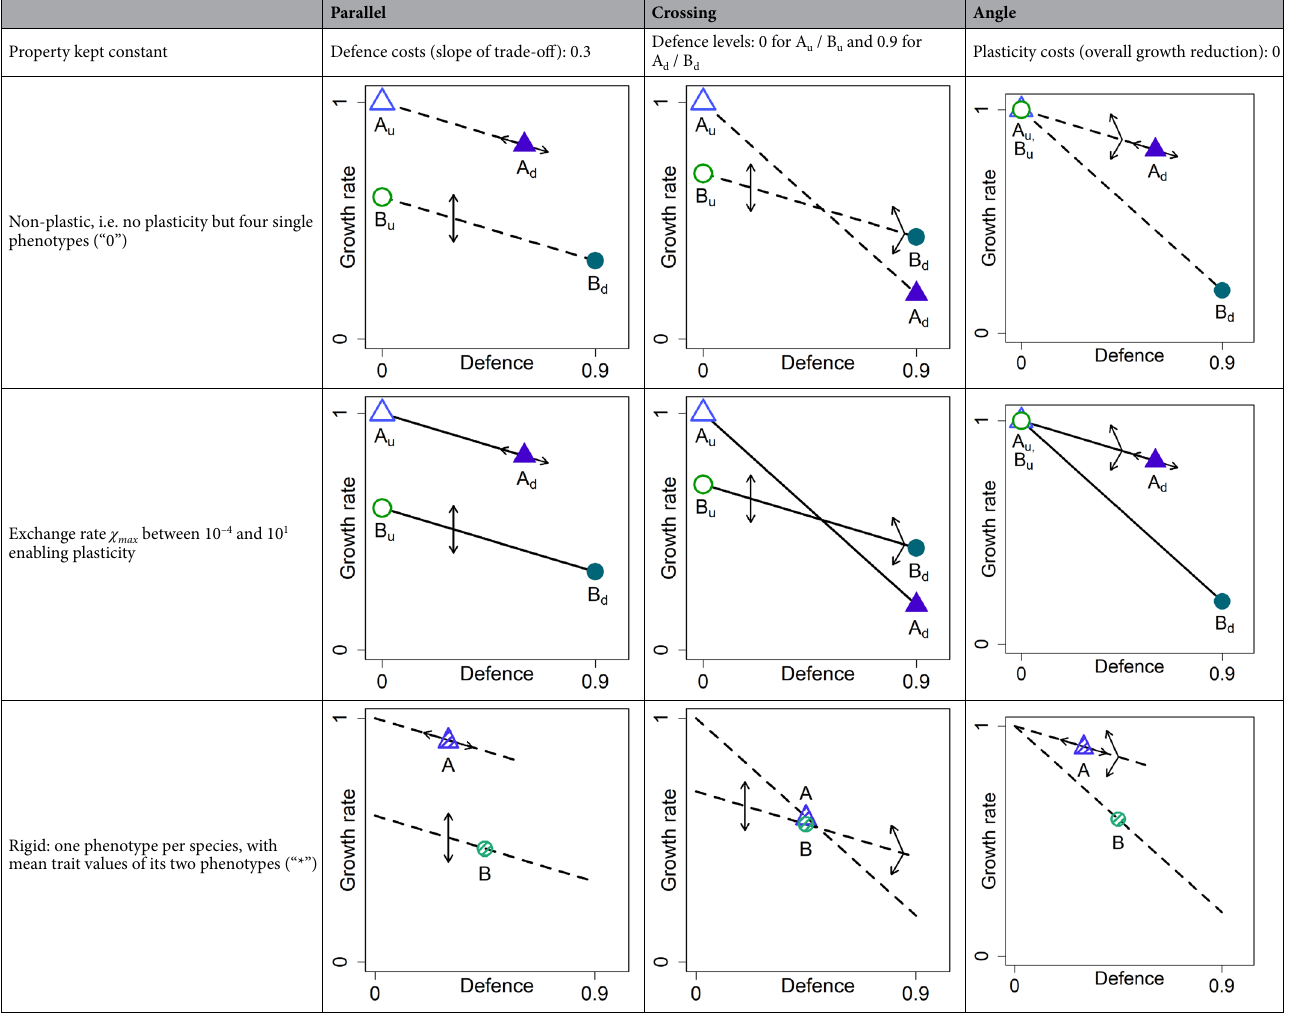
Table 1. Description of the three constellations parallel , crossing , and angle defining the position of the four phenotypes in the trait space of defence and growth rate. Autotrophs are denoted by symbols (open triangle undefended phenotype of species A, A u , filled triangle defended phenotype of species A, A d , open circle undefended phenotype of species B, B u , filled circle defended phenotype of species B, B d , shaded triangle rigid A , shaded circle rigid B ), the arrows describe the properties being varied in the simulations and the lines connect both phenotypes of a species, whereby only solid lines express actual switching between phenotypes. “0” and “*” denote the non-plastic and the rigid scenario of the respective constellation, i.e. the non-plastic scenarios are referred to as e.g. parallel 0 in the text, the rigid ones as e.g. parallel * . The plastic scenarios are referred to by their maximum switching rate, e.g. parallel 0.01